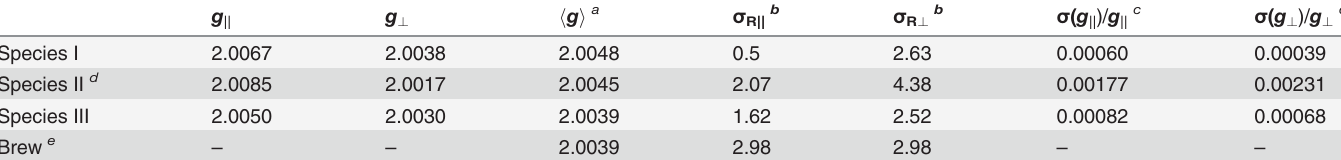
Table 1. Spin Hamiltonian parameters determined from numerical simulation of the experimental EPR spectra. g